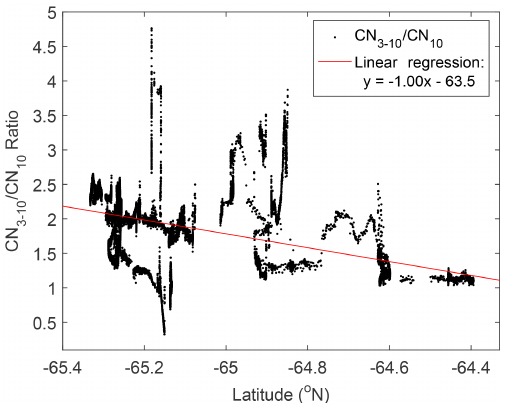
Figure A6. The ratio CN 3 − 10 / CN 10 is shown only for polar cell latitudes. The new particle formation event on the 18 October (Humphries et al., 2015) was removed to result in a background data set. The linear regression shows a substantial increase with